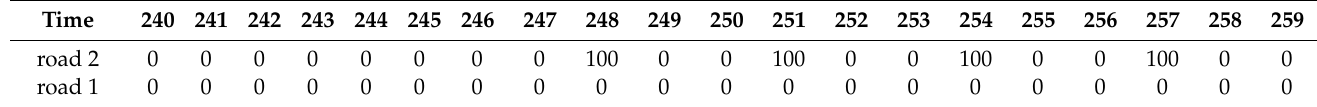
Table 1. Flow ratio (%) of roads 2 and 1 to road